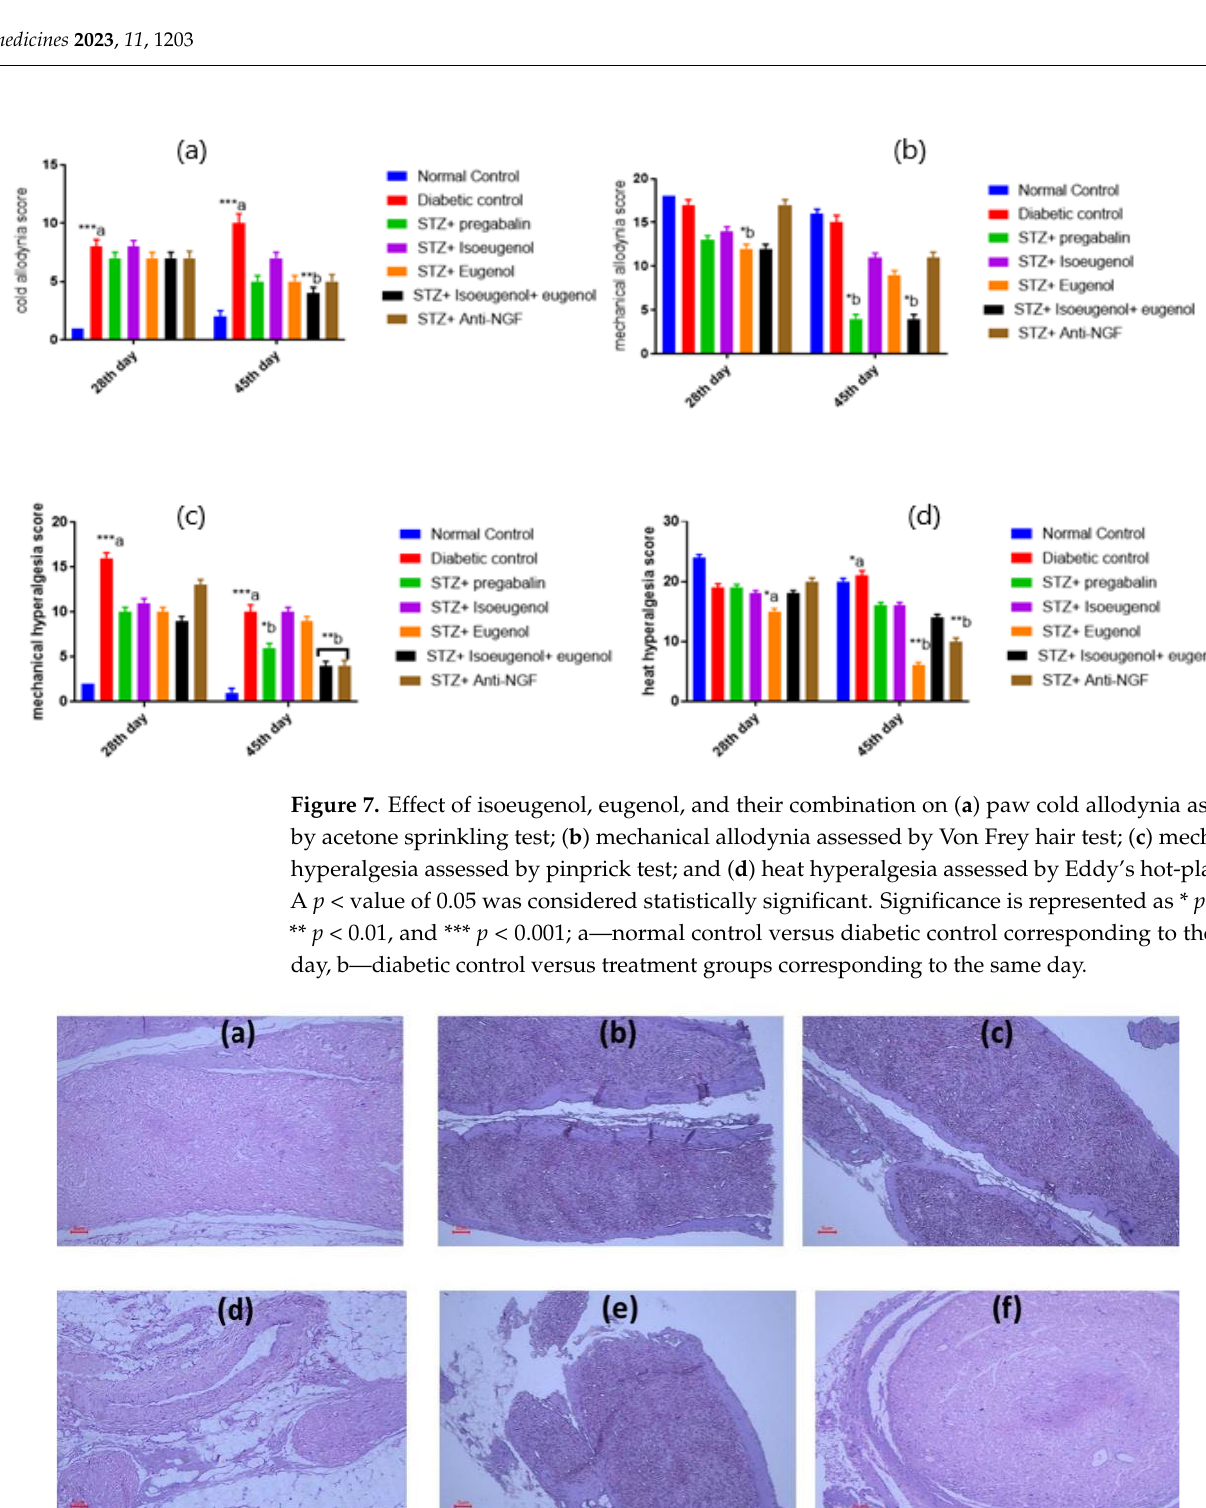
Table 3. Histologic score of sciatic nerve lesions in different groups.